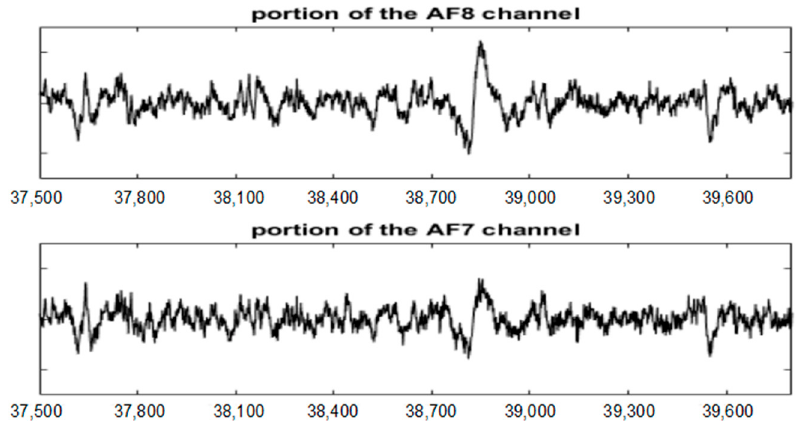
Figure 10. The undetected artefact in the EEG portion [37,500 39,800] of the channels AF8 and AF7.